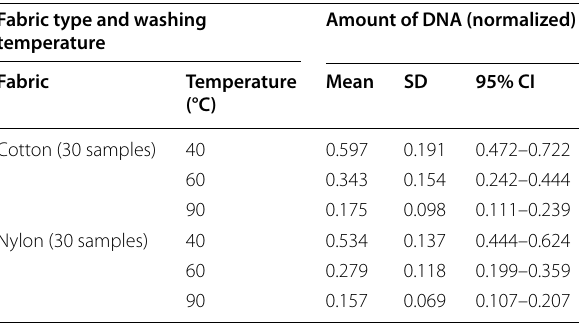
Table 4 Statistical parameters for the amount of extracted DNA from 60 samples as cotton and nylon by using spin colon extraction